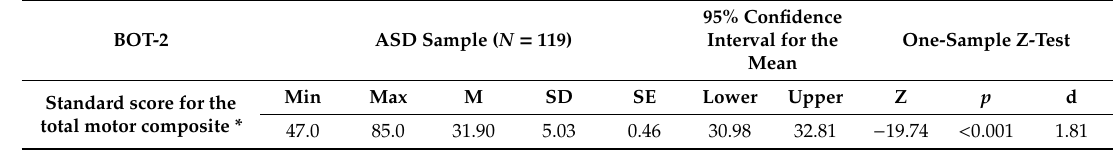
Table 3. Descriptive Statistics and Z-Test Results Concerning the Total Motor Composite.